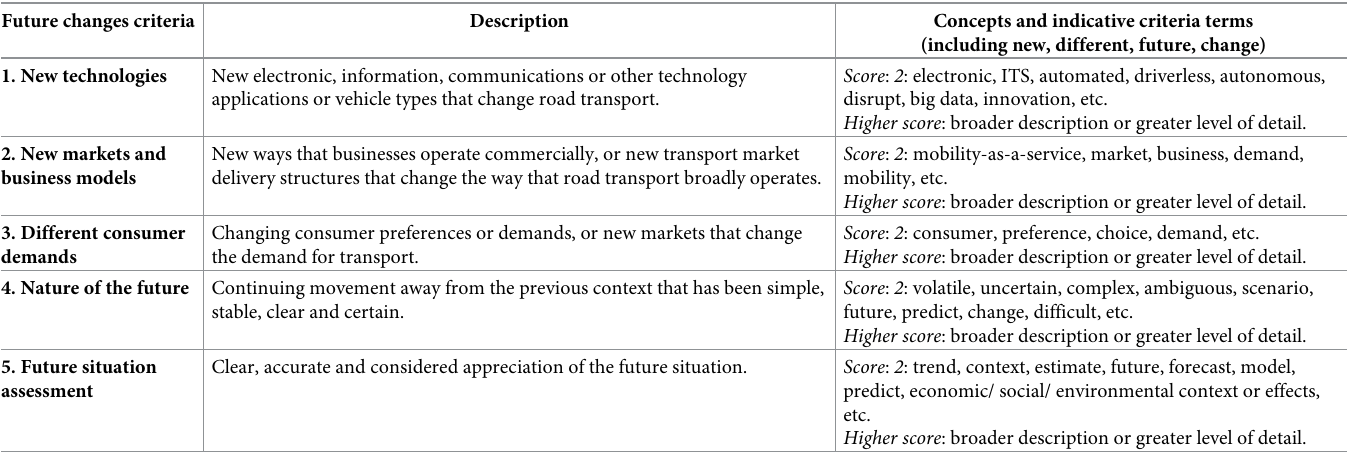
Table 3. Summary of future changes criteria and